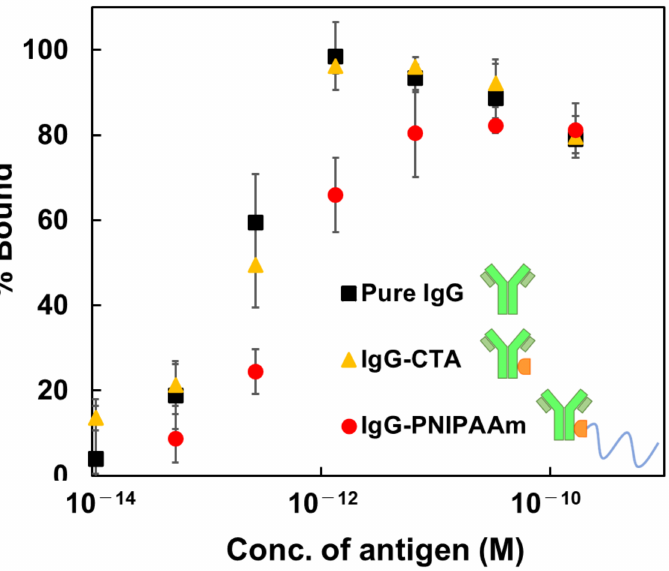
Figure 9. Effect of antigen concentration on the antigen–antibody reaction measured using ELISA (mean ± SD, n =